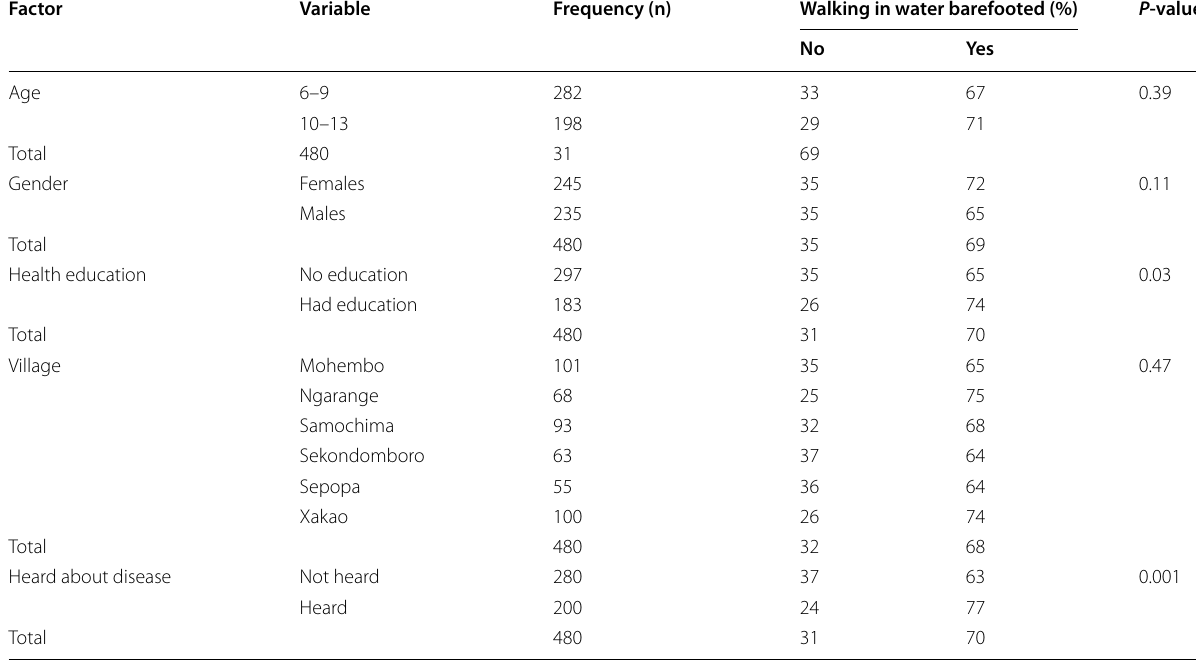
Table 6 Knowledge Walking in Water Barefooted by Socio‑Demographics